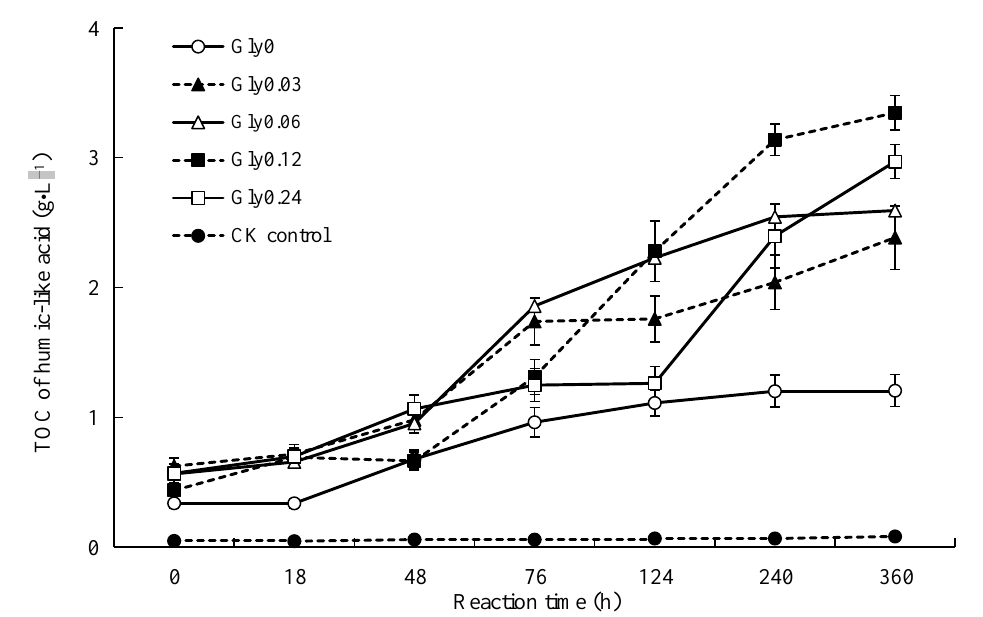
Figure 3. Effects of the glycine with different concentrations in the Maillard precursors on C HLA extracted from the dark-brown residue.